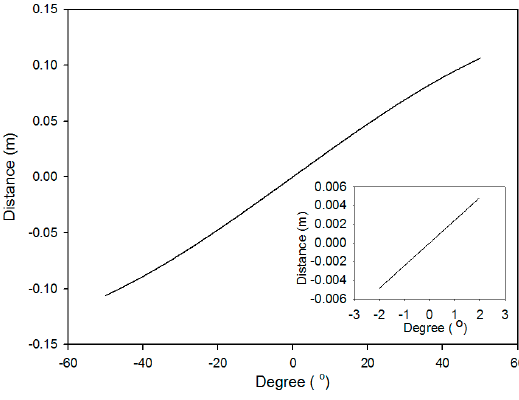
Figure 2. Relationship between Δθ and Δ Z .